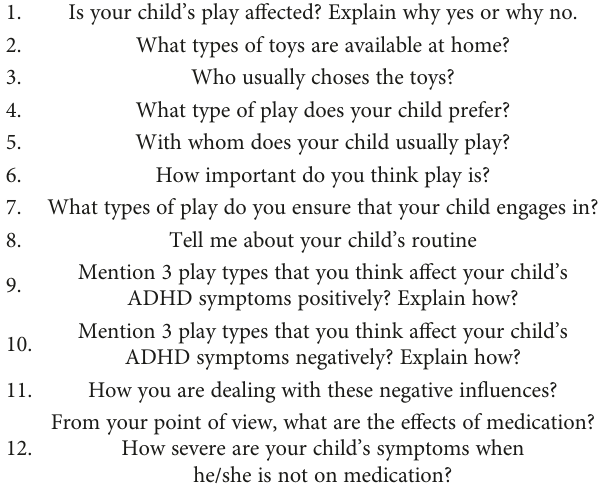
Table 2: Interview